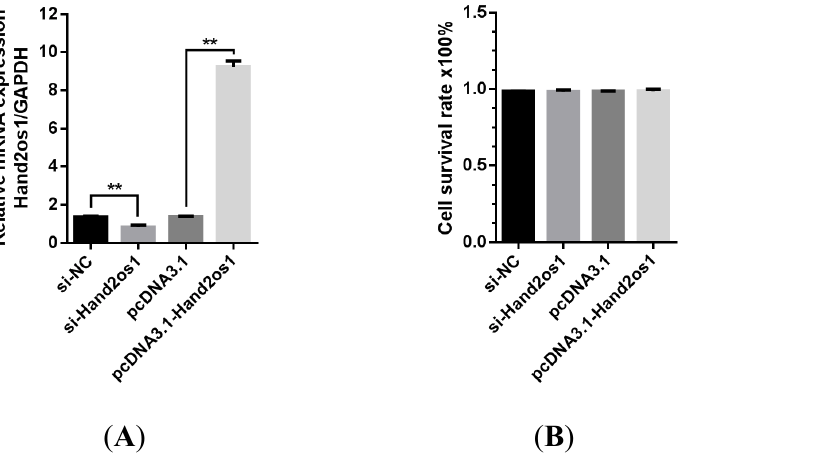
Figure 3. Effects of Hand2os1 on proliferation and apoptosis in mouse LCs collected on day 4 of pregnancy. ( A ) The efficiency of Hand2os1 silencing and overexpression were determined using qRT-PCR 24 h after transfection with si- Hand2os1 and pcDNA3.1- Hand2os1 , respectively. GAPDH was used as the reference gene for normalization. ( B ) The proliferation of LCs was determined by CCK-8 assays after silencing or overexpression of Hand2os1 for 24 h. ( C ) The apoptosis of LCs was analyzed by FCM after transfection with the Hand2os1 overexpression vector, followed by treatment with 1 μ M PGF 2 α for 24 h. The data represent the mean ± SEM from three independent experiments. ** p < 0.01 compared with si-NC group, and different number of asterisks on bars indicate significant differences ( p < 0.05).